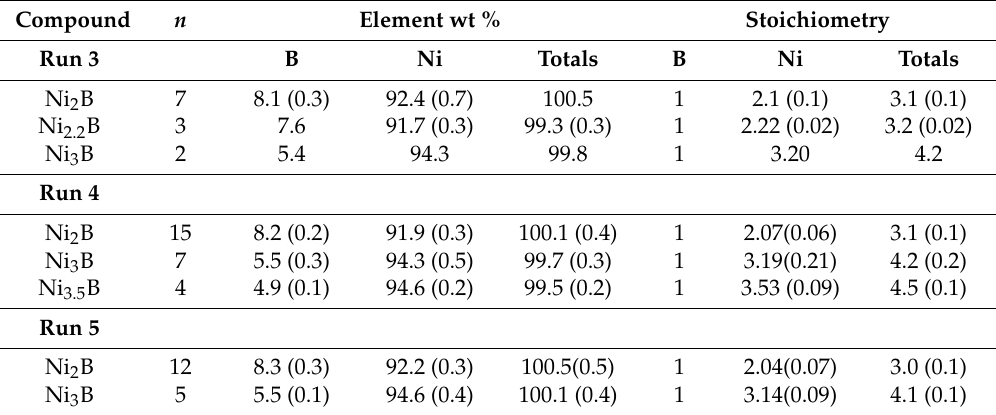
Table 3. Average compositions of selected regions in aggregates from Run 3, Run 4, and Run